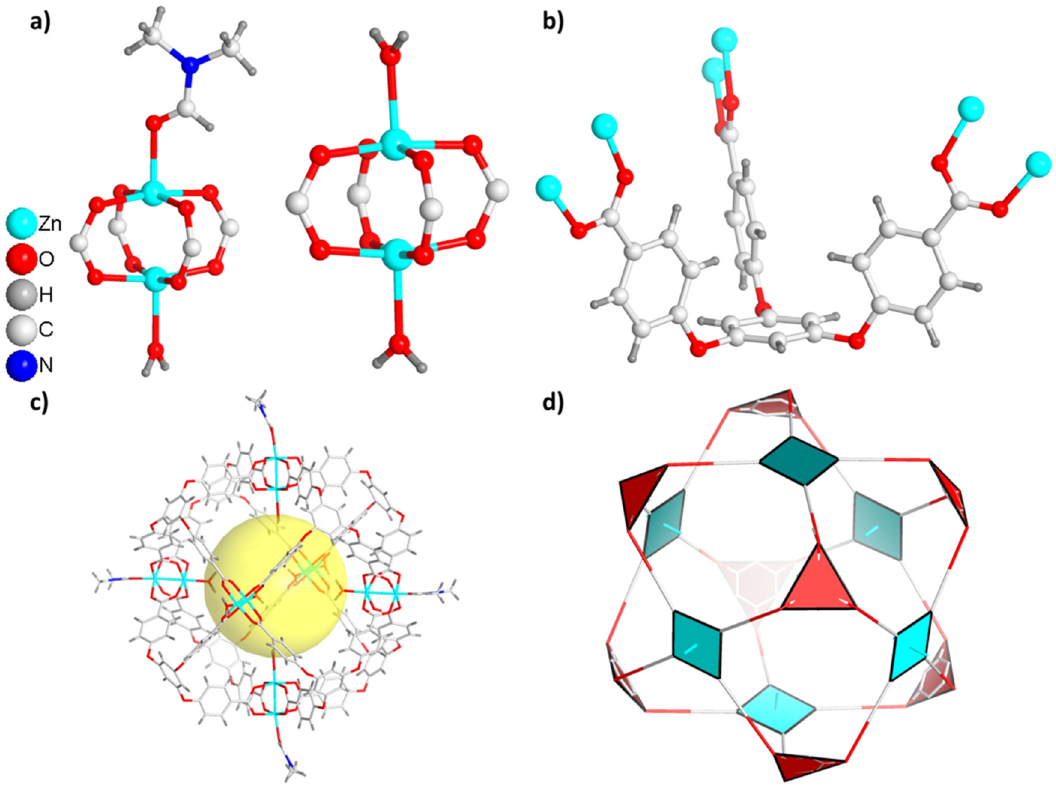
Figure 1: ( a ) View of the two di ff erent types of binuclear Zn clusters of 1 ( the atom legend is shown in the left of this fi gure ) . ( b ) View for the coordinated mode view for ligand L 3 − . ( c ) The cage type skeleton for the complex 1 . ( d ) The simpli fi ed network for complex 1